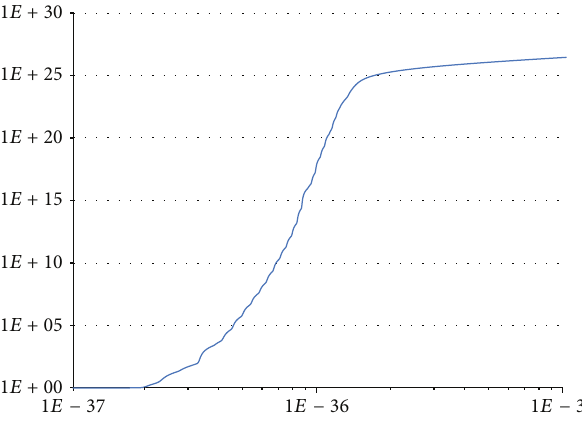
Figure 1: The scale factor for the inflationary period (log-log scale).